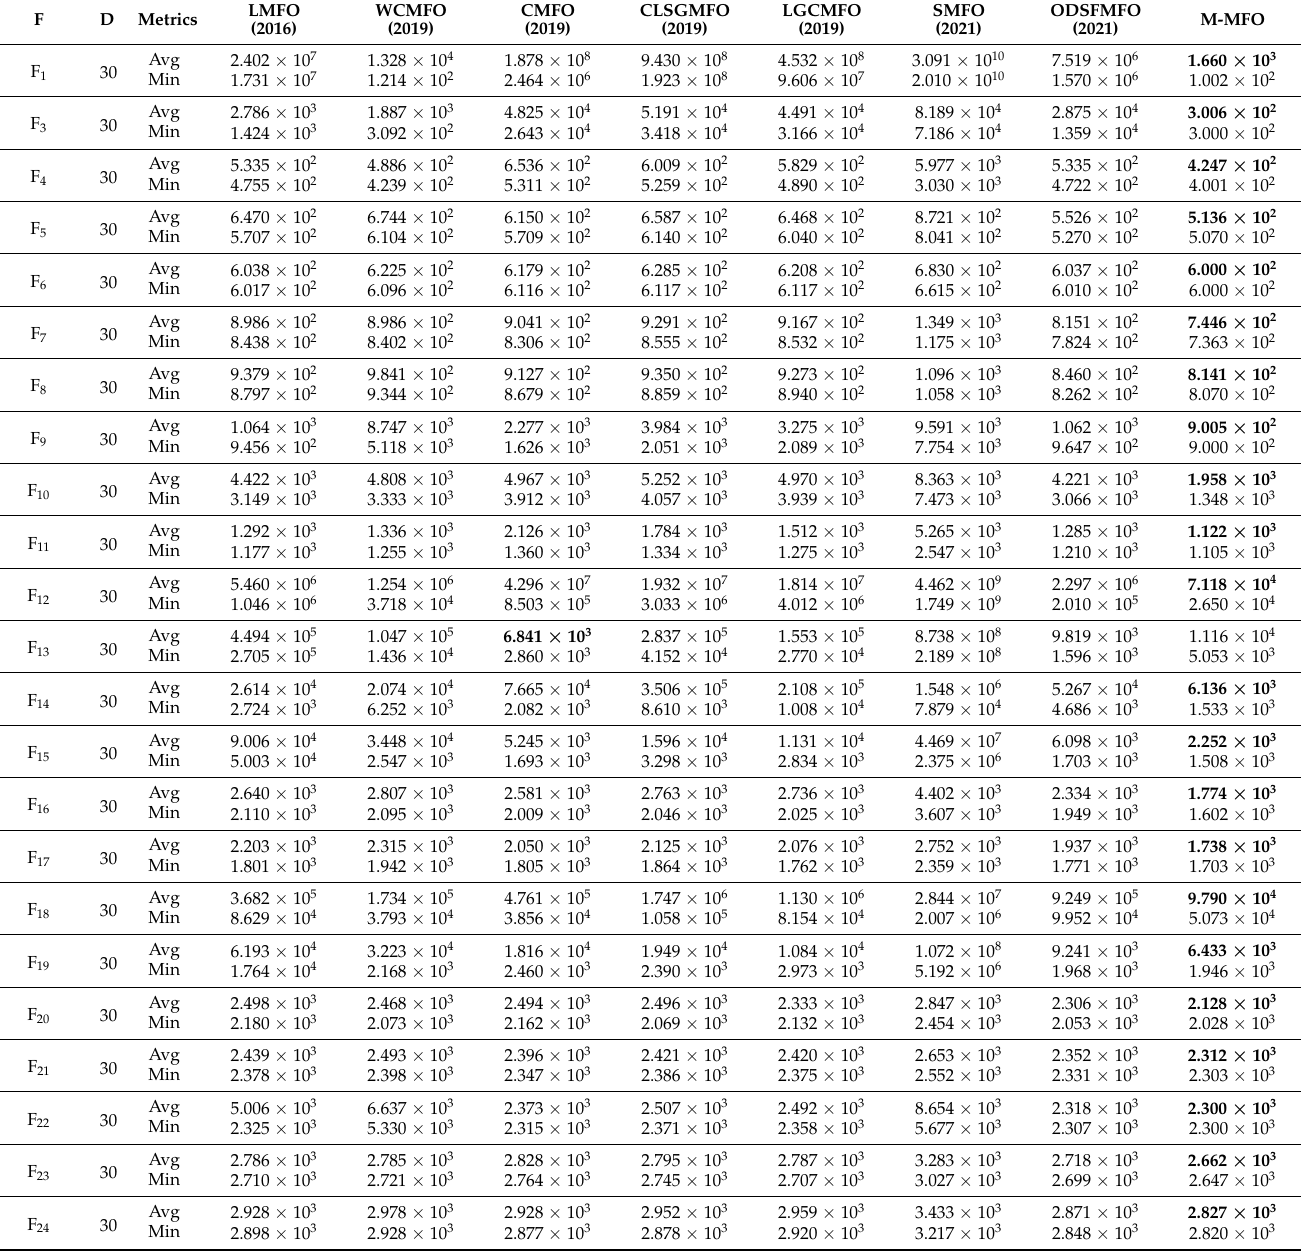
Table A1. Comparison results of MFO